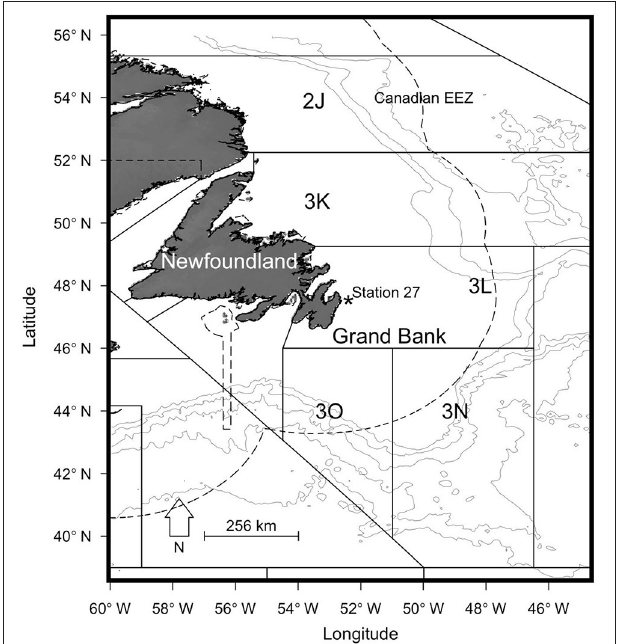
FIGURE 1 | Map of the study area, showing the Grand Bank (NAFO division 3LNO), Station 27, and the Canadian exclusive economic zone (dashed lines).